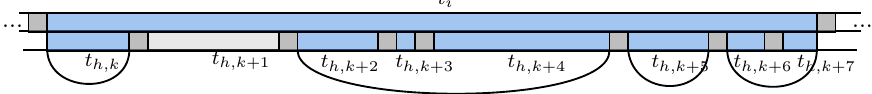
Figure 3. The decomposition from a generating call for t i = t h , k d h , k t h , k + 1 d h , k + 1 . . . d h , k (cid:48) − 1 t h , k (cid:48) . Here, t h , k + 1 is in light gray meaning that we invoke a generating call for it; for other parts, t i is split into four chunks t h , k , t h , k + 2 d h , k + 2 t h , k + 3 d h , k + 3 t h , k + 4 , t h , k + 5 , t h , k + 6 d h , k + 6 t h , k + 7 , each of which has a block-aligned earlier